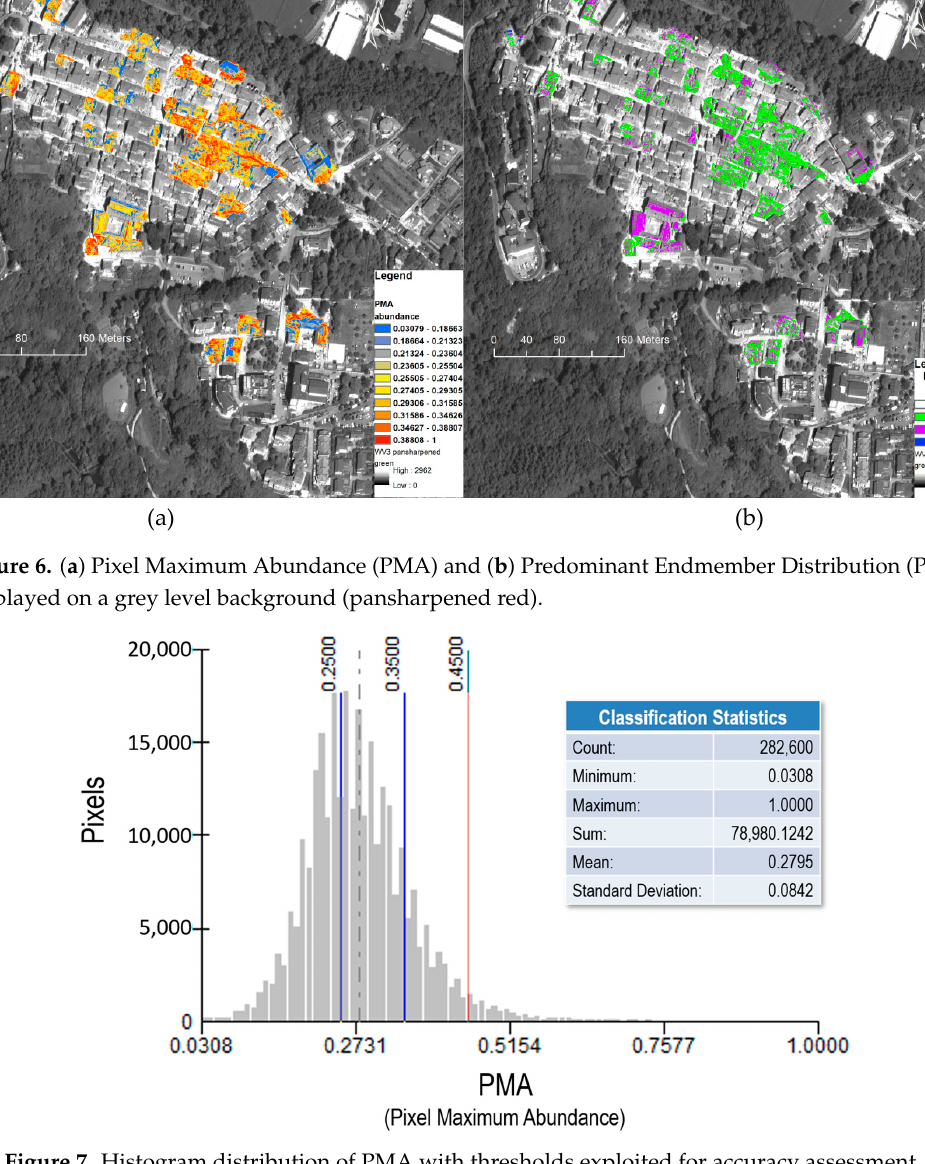
Figure 7. Histogram distribution of PMA with thresholds exploited for accuracy assessment. In Figure 8 the recoded PED distribution obtained using a 0.25 PMA threshold is displayed.